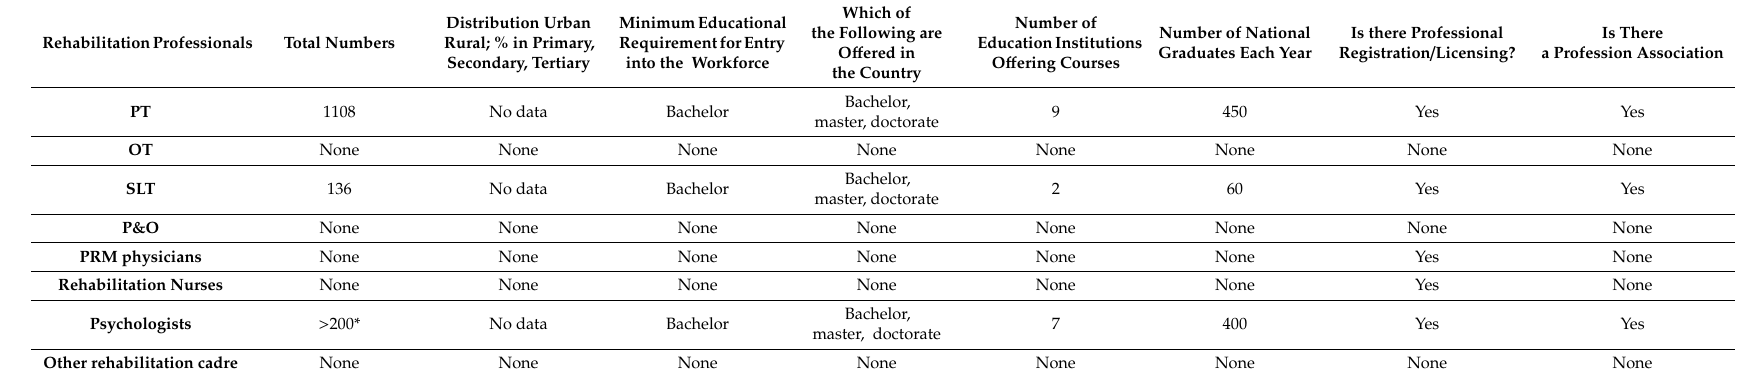
Table 1. Data of rehabilitation professions in